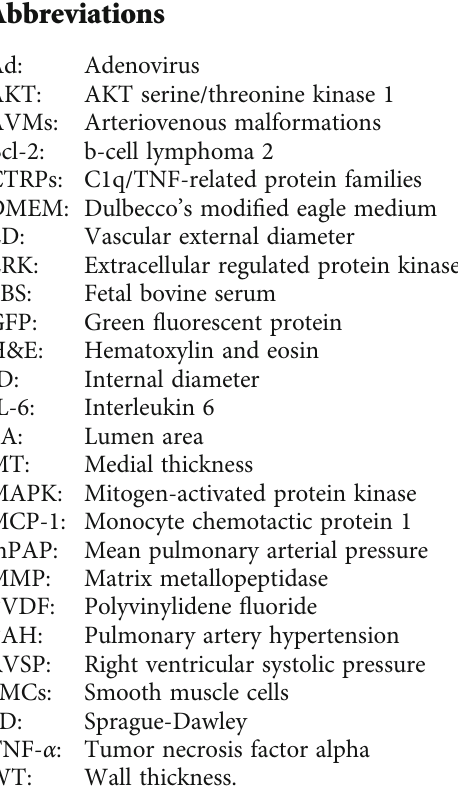
Supplementary Table 1: sequences of primers used for qRT- PCR analysis in rat lung tissue. (Supplementary